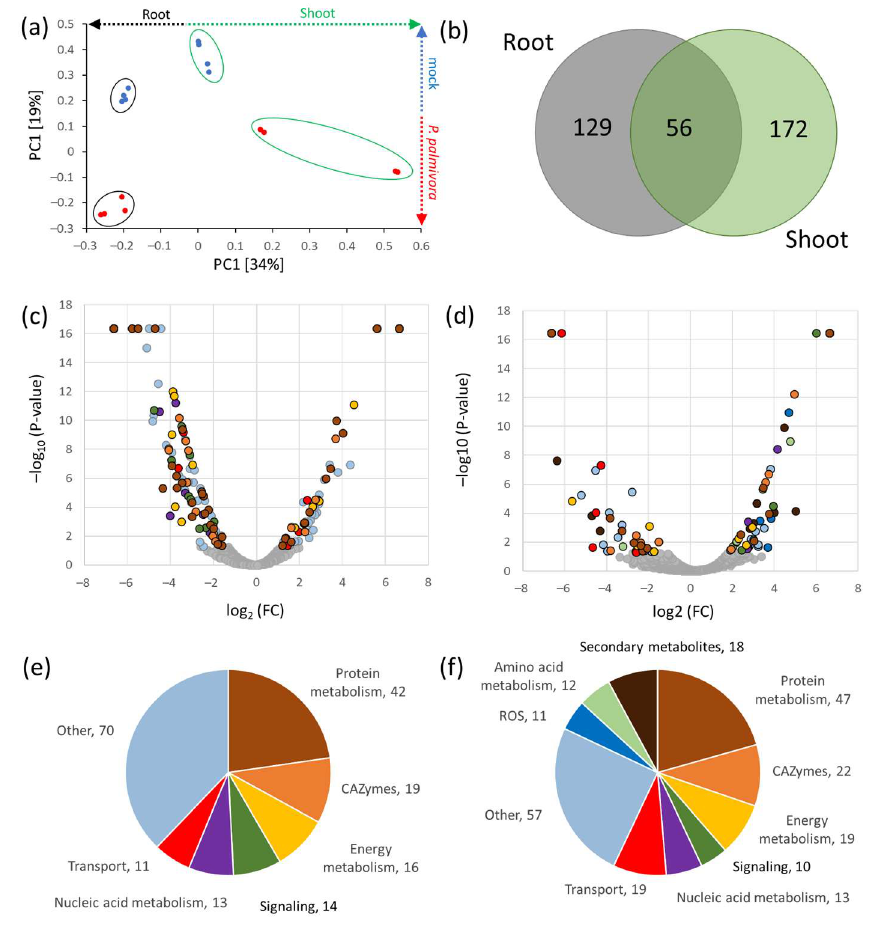
Figure 3. Barley proteome response to P. palmivora . ( a ) The proteome profile separation of P. palmivora -treated and mock-treated samples. Principal component analysis based on differentially abundant proteins in shoots and roots. Results of four biological replicates represent proteins with at least two matched unique peptides. Mock-treated plants (blue) and plants inoculated with P. palmivora (red) are indicated. Circles represent statistically significant separation (Kruskal–Wallis test, p < 0.05), black and green color corresponds to root and shoot tissue, respectively. ( b ) The overlap between differentially abundant proteins in shoots and roots (absolute fold change FC > 1.5; p < 0.05). ( c – f ) Volcano plot representation and functions of P. palmivora response proteins in barley roots ( c , d ) and shoots ( d , f ). Only categories represented by more than nine proteins are highlighted. The color of spots representing differentially abundant proteins in panels ( c , d ) corresponds to categories highlighted in ( e , f ).